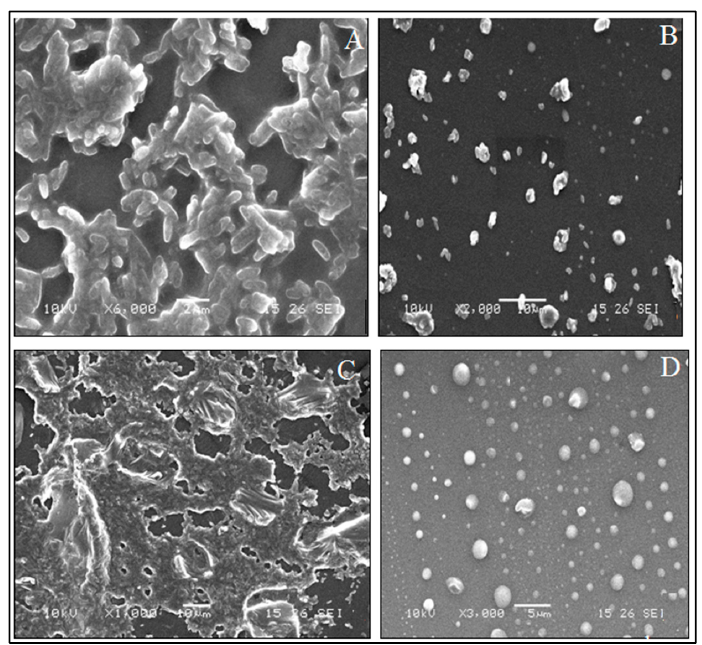
Figure 9. Scanning electron microscope (SEM) images of polydimethylsiloxane (PDMS) disc with ( A , C ) and without biofilms ( B , D ) formed by bacterial cultures. The upper row ( A , B ) represents for P. valgaris NCIM 2027 and lower row ( C , D ) represents for B. subtilis MTCC 2423. Figure ( A ) and ( C ) represent the control surfaces indicating the PDMS disc without any biosurfactant (BS) coating where confluent growth of biofilms is seen. Whereas, Figure ( B ) and ( D ) represents the test surfaces indicating pre-coating with BS inhibiting not only the adherence but also the growth of bacteria; proving the antiadhesion and antibiofilm potential of BS.